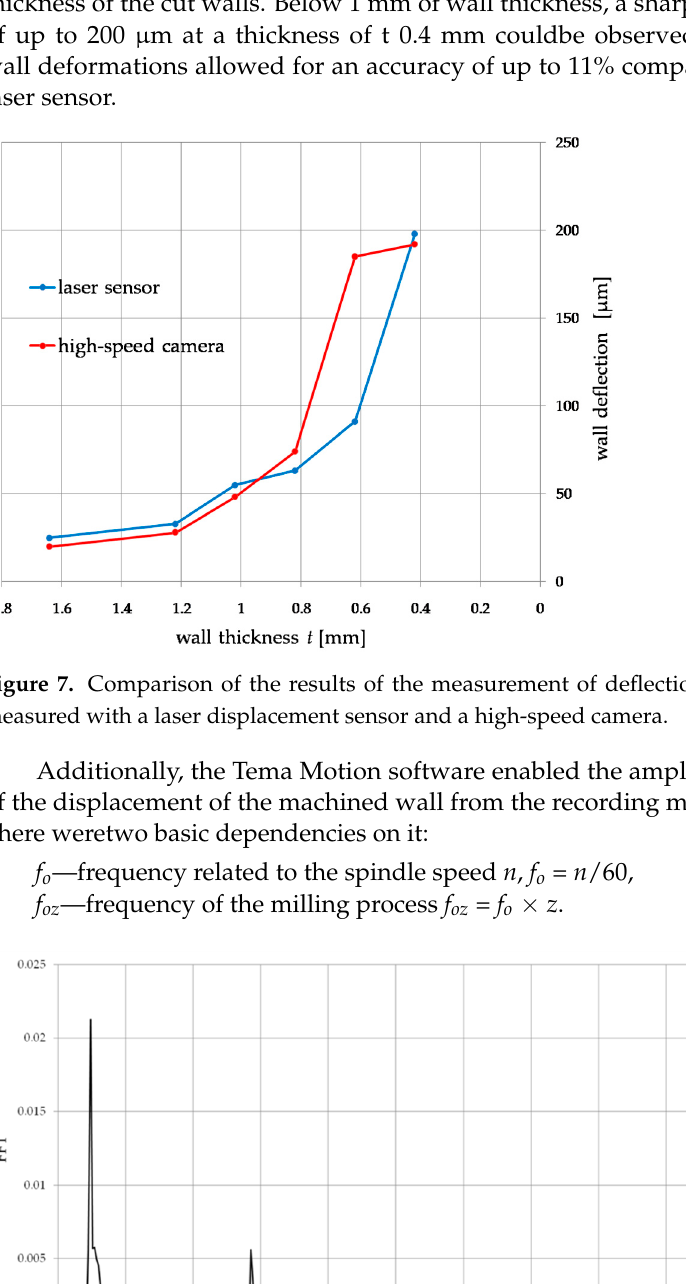
Figure 6. The plot of the deflection of the thin-walled workpiece obtained by measuring the deformation with a displacement laser sensor.